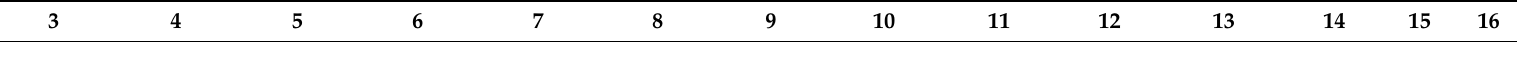
Table 3. Bivariate correlations for the